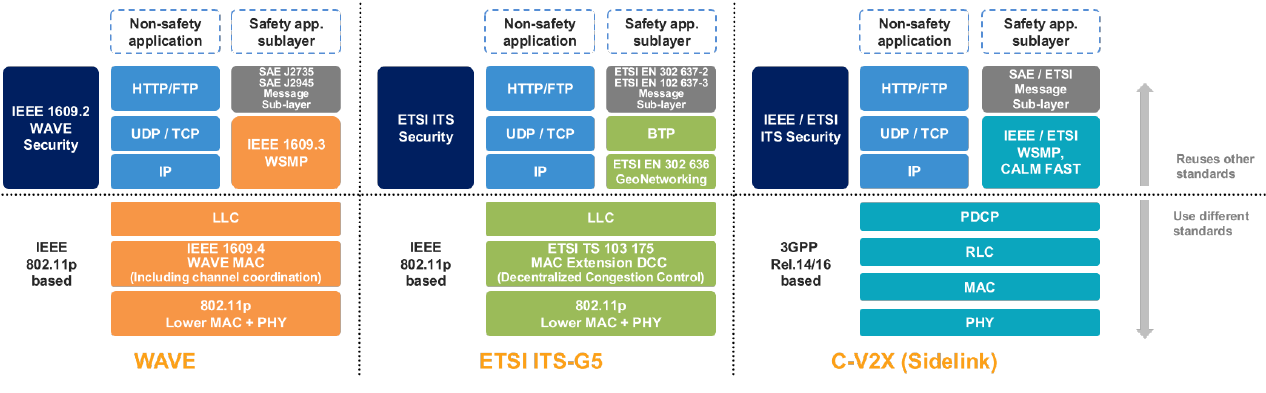
Figure 3. Comparison of ITS stacks by V2X protocol. WAVE uses U.S. standards, and ETSI ITS- G5 uses European standards. In C-V2X, the lower-level layer uses 3GPP specifications, and the higher-level layer can apply U.S. and European standards.